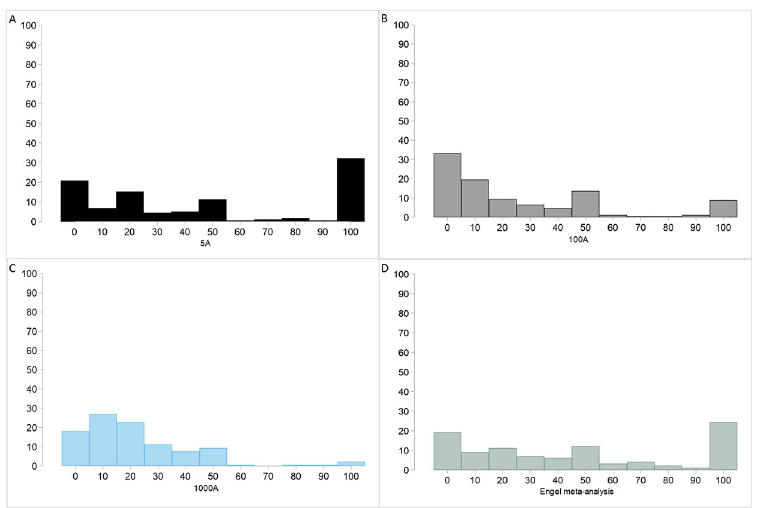
Fig 3. Distribution of donated shares across treatments (%). A. 5 € . B. 100 € . C. 1,000 € . D. Donations to deserving recipients in Engel’s meta-study